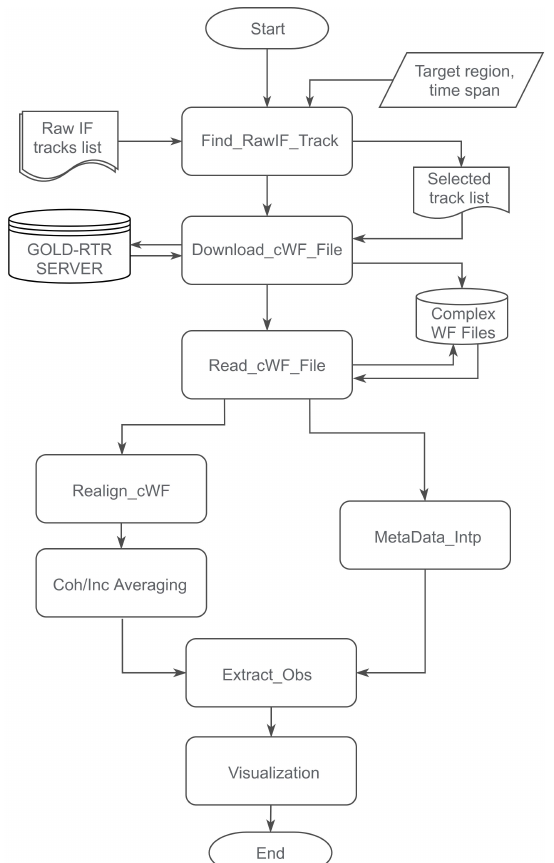
Figure 5. An example scheme for accessing, searching and analyzing the complex waveform